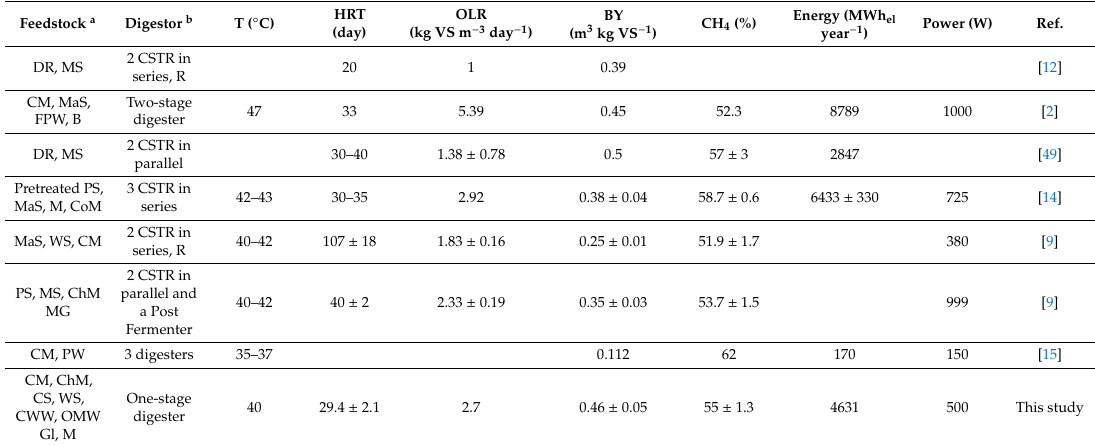
Table 5. E ff ects of feedstock and operation on biogas production in the full-scale